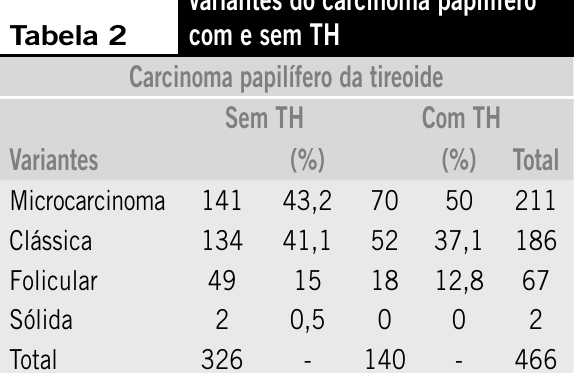
( Figura ). Foram excluídos seis casos que apresentavam doença metastática para tireoide.